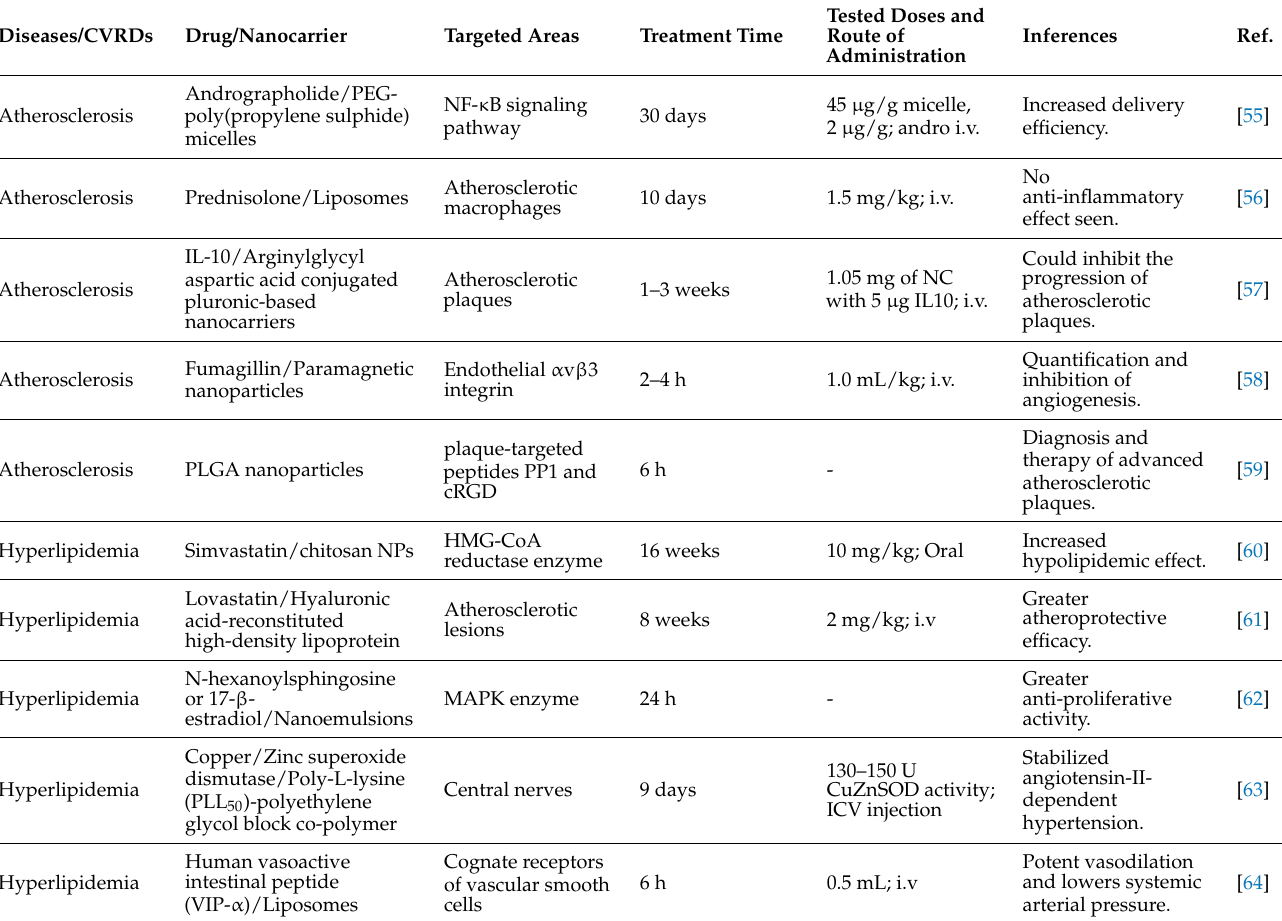
Table 2. Different targeted/theranostic approaches of nanomedicine for